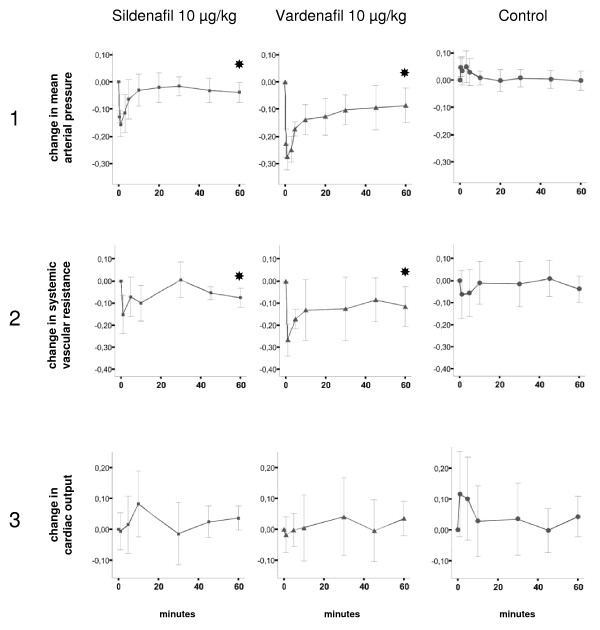
Course of relative changes of systemic hemodynamic parameters after slow intravenous injection of 10 μg/kg sildenafil or vardenafil or 0.9% NaCl. Ordinate: time (minutes). Abscissa: relative change (e.g. 0.00 means baseline; 0.10 means: increase by 10%; -0.10 means: decrease by 10%). The values are indicated as mean ± 95% confidence intervals. Significant changes at 60 min (p < 0.05; Wilcoxon rank sum test) are marked with black stars. Panel 1: Mean arterial pressure. Panel 2: Systemic vascular resistance. Panel 3: Cardiac output.